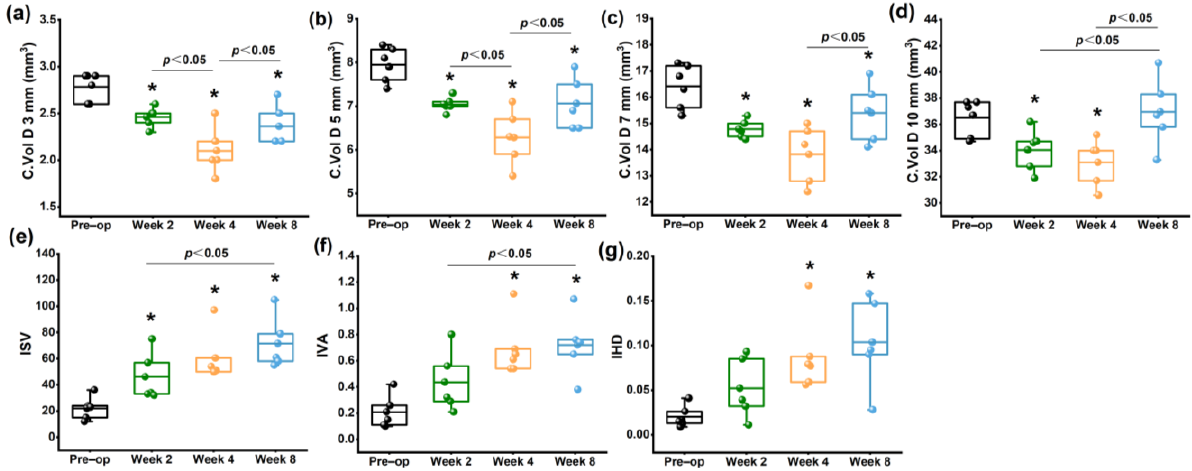
Figure 4. Changes in corneal volume and corneal morphological variation index measured by Pentacam. ( a ) C. Vol D 3 mm; ( b ) C. Vol D 5 mm; ( c ) C. Vol D 7 mm; ( d ) C. Vol D 10 mm; ( e ) ISV; ( f ) IVA; ( g ) IHD. * p < 0.05 vs. preoperative group.